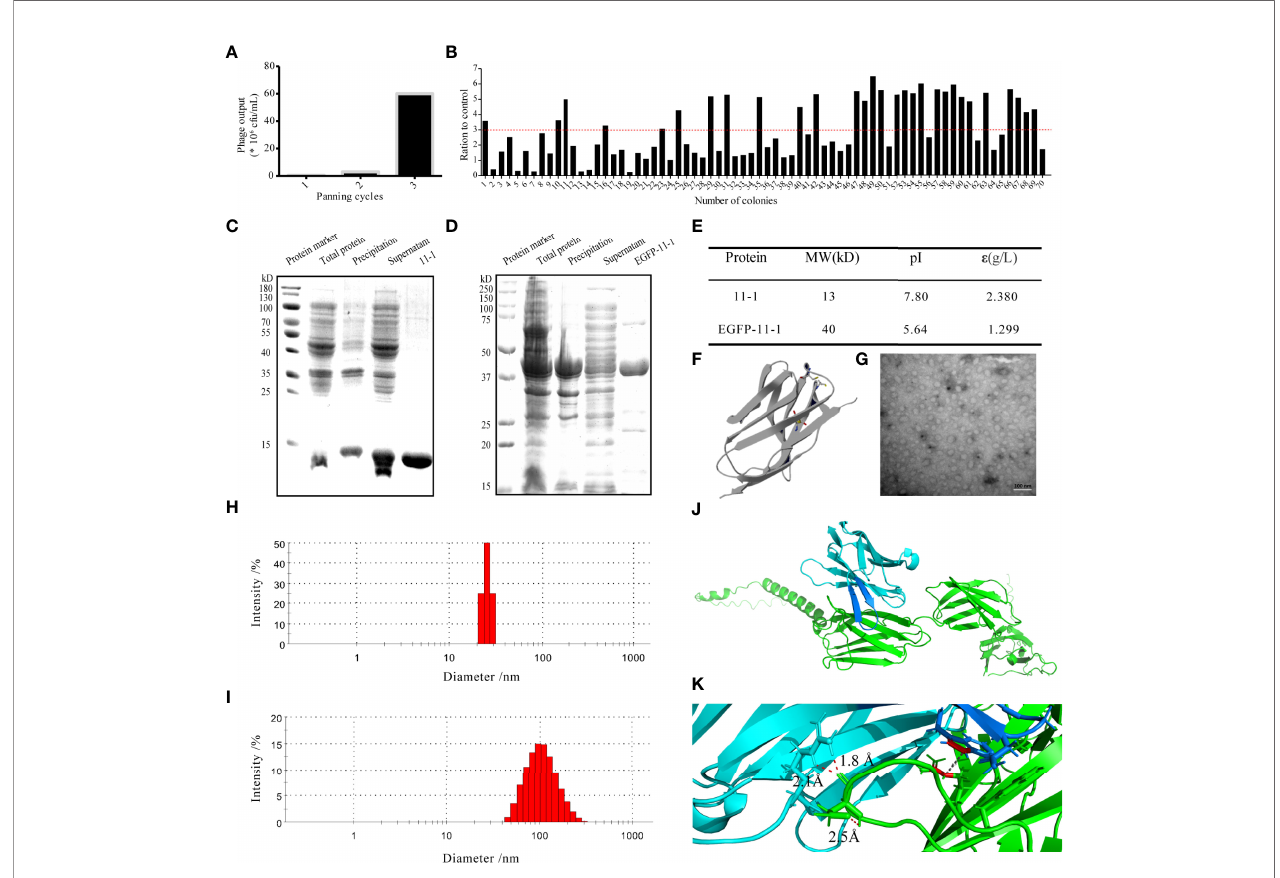
FIGURE 2 | The characterization of the candidate anti-CD147 Nb 11-1. (A) Enrichment over three rounds of panning. The histogram shows the enriched quantities and the enriched fold changes after each round. (B) Phage ELISA for the selection of 70 colonies from the three rounds. Positivity was de fi ned by positive/negative ratios >3. (C, D) Analysis of Nb 11-1 (C) and EGFP-11-1 (D) expression and puri fi cation by SDS – PAGE. (E) Properties of Nb 11-1 and EGFP – 11-1, determined using the ExPASy ProtParam tool. (F) The predicted spatial structure of Nb 11-1. (G) The TEM image of Nb 11-1 (scale bar = 100 nm). (H, I) The particle size distribution of Nb 11-1 (H) and EGFP-11-1 (I) . (J) The docking analysis between Nb 11-1 (cyan and blue) and CD147 (green). (K) The enlarged image from J to show the involving amino acids of Nb 11-1 in the interaction with CD147 via AlphaFold2